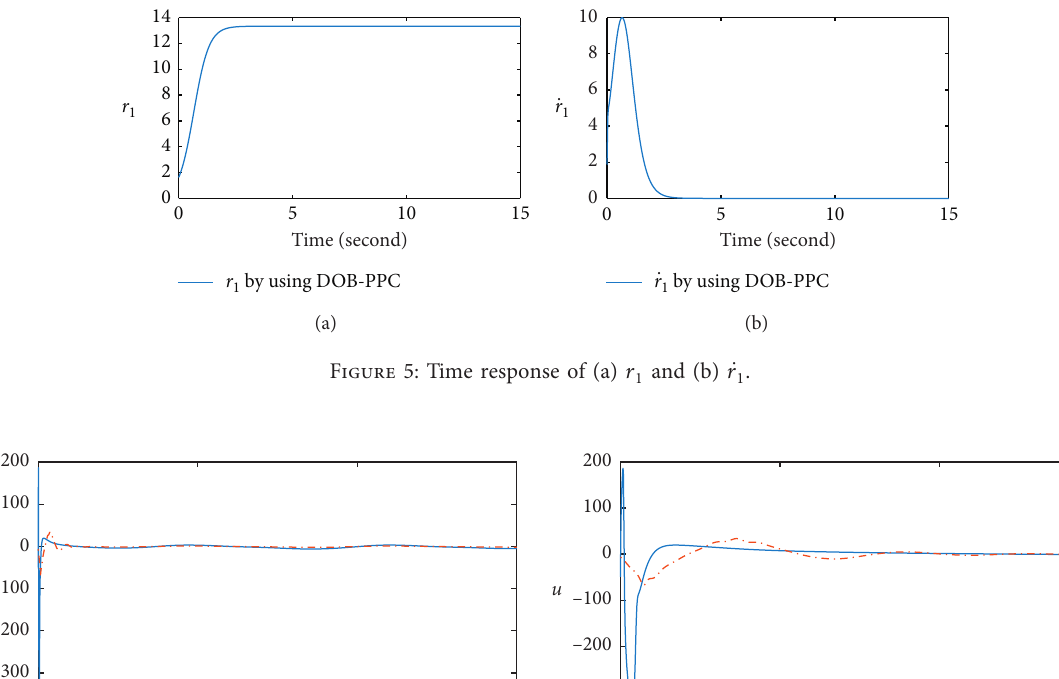
Figure 4: Estimation of f DOB-PPC in time period (c) [0, 15s]; (d) [10s, 15s].